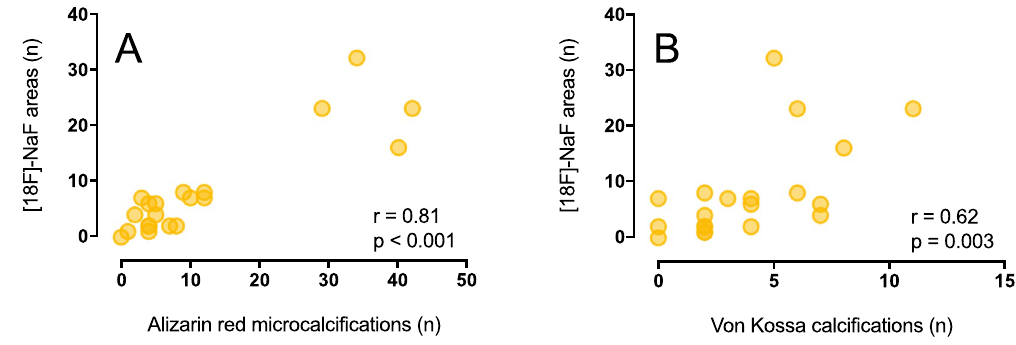
Figure 3. Correlation of the number of [ 18 F]-sodium fluoride ([ 18 F]-NaF) areas with Alizarin red stained microcalcifications ( A ) and Von Kossa stained calcifications ( B ).